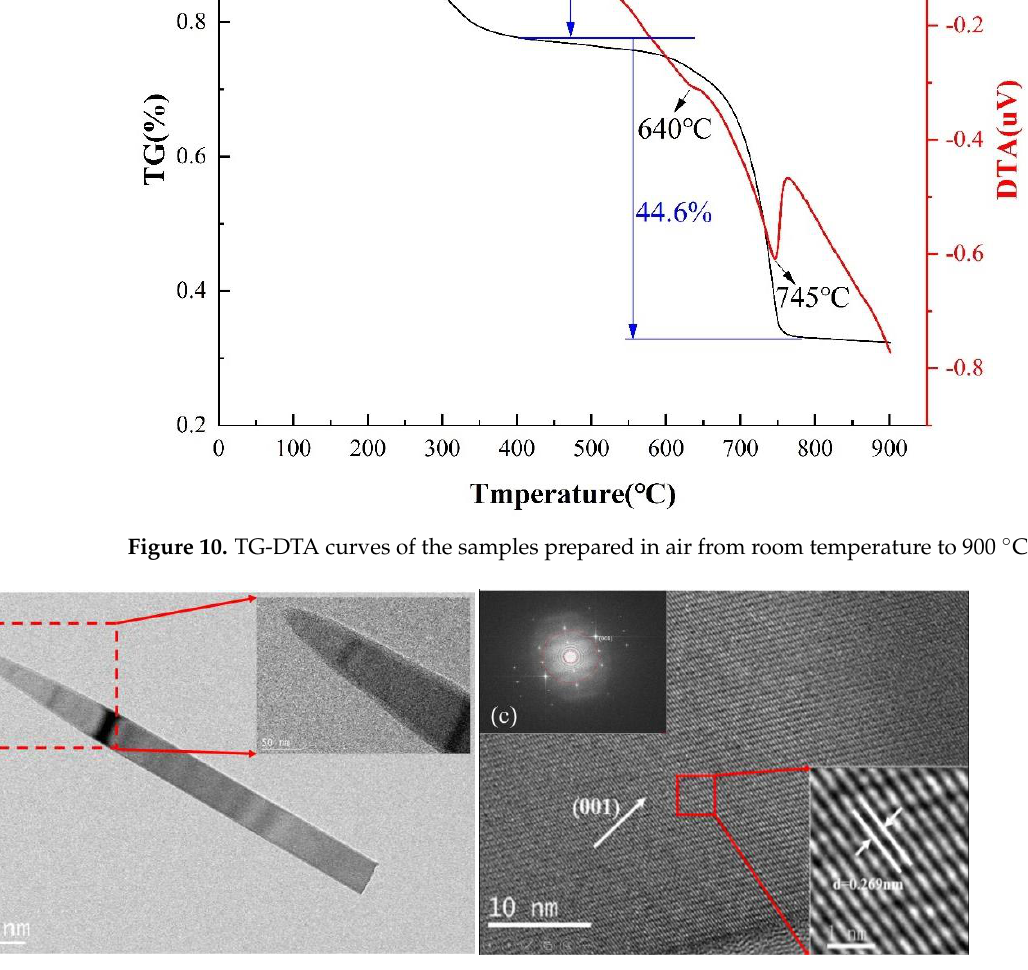
Figure 10. TG-DTA curves of the samples prepared in air from room temperature to 900 °C.